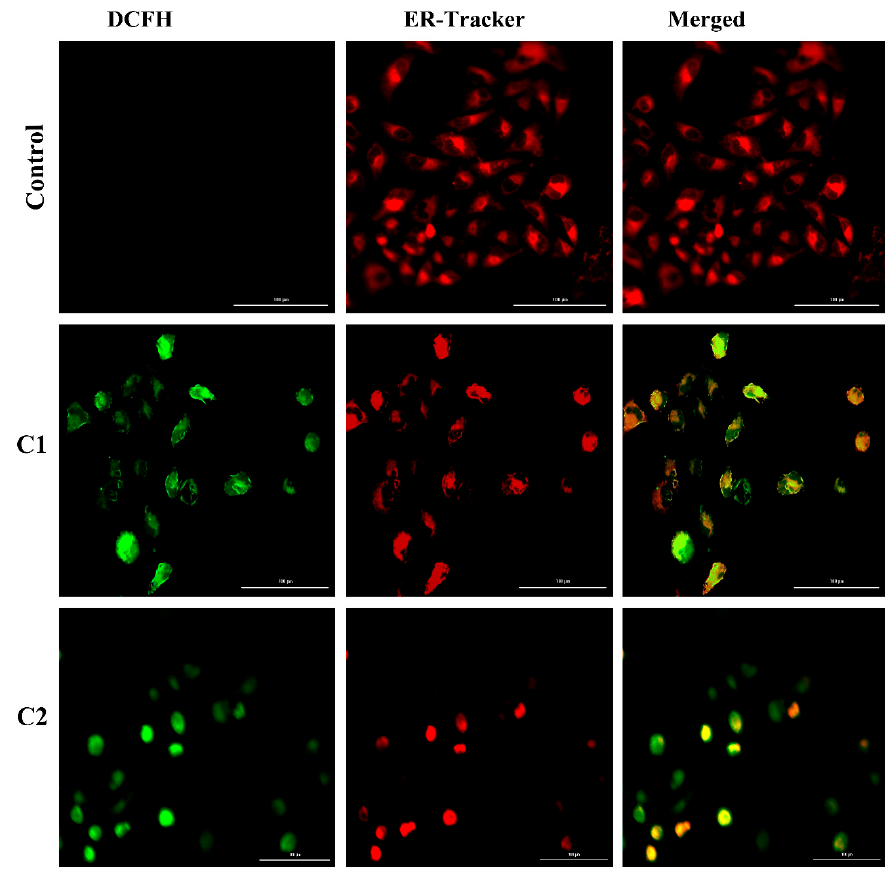
Figure 8. Generation of ROS by using 2 ʹ ,7 ʹ -dichlorofluorescein (DCF) and analysis of ER-tracker red by binding to sulfonylurea receptors in the ER. binding to sulfonylurea receptors in the